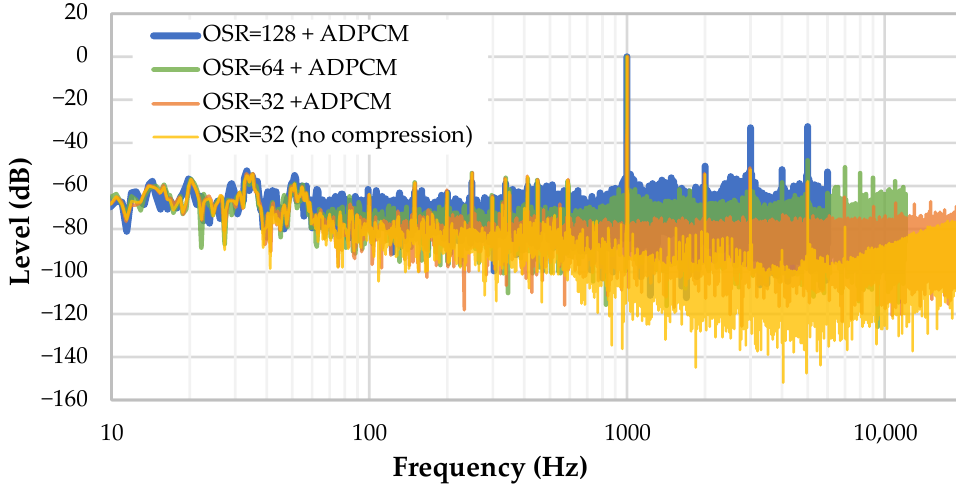
Figure 17. Effect of ADPCM compression on the noise floor, for various values of OSR.